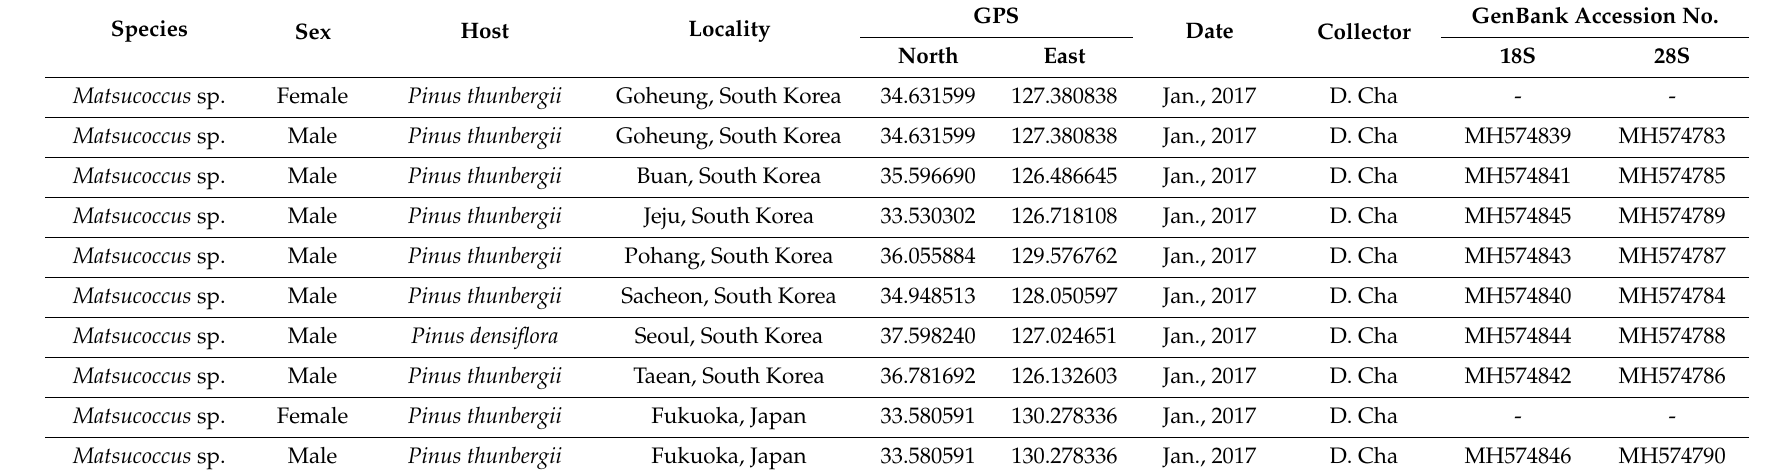
Table 1. Collection data of samples used in this study (GPS coordinates; WGS84 coordinate